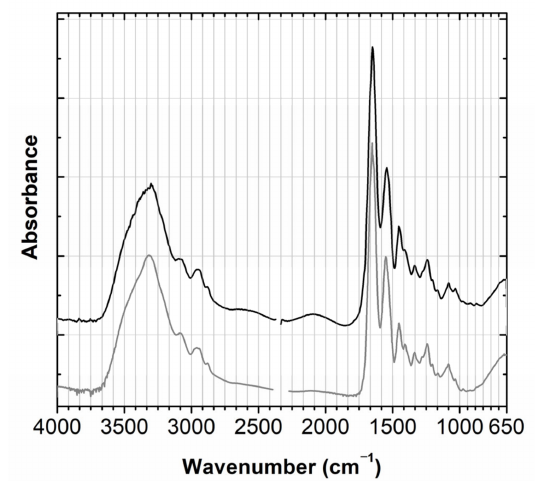
Figure 9. Infrared spectrum of the glue used to fix the moss to the base (black) compared with a parchment glue reference